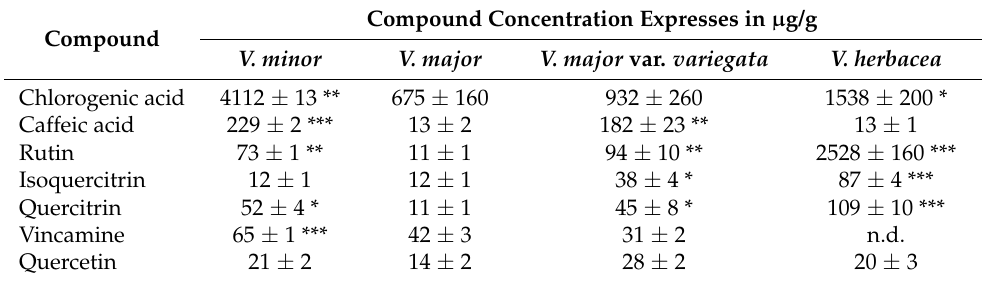
Figure 1. ( a ) HPLC-DAD chromatograms of the Vinca minor , V. major , V. major var. variegata , and V. herbacea plant extracts monitored at 230 nm. Chromatogram of analytical standards includes: (1) 3,4-dihydroxybenzoic acid, (2) chlorogenic acid, (3) 4-hydroxybenzoic acid, (4) caffeic acid, (5) syringic acid, (6) rutin, (7) p -coumaric acid, (8) isoquercitrin, (9) ferulic acid, (10) quercitrin, (11) myricetin, (12) berbamine, (13) vincamine, (14) jatrorrhizine, (15) quercetin, (16) palmatine, (17) berberine, (18) kaempferol, (19) vinblastine, and (20) galangin. The identified compounds in the studied Vinca species are marked in green in the upper chromatogram; ( b ) UV molecular absorption spectra as registered by the DAD detector for the representative standards from each main phytochemical group (grey-hydroxybenzoic acids, green-cinnamic acids, blue-flavonoids, and red-alkaloids). Table 1. Concentration of the main phytoconstituents identified in the Vinca minor , V. major , V. major var. variegata , and V. herbacea leaf extracts as determined and calculated from HPLC